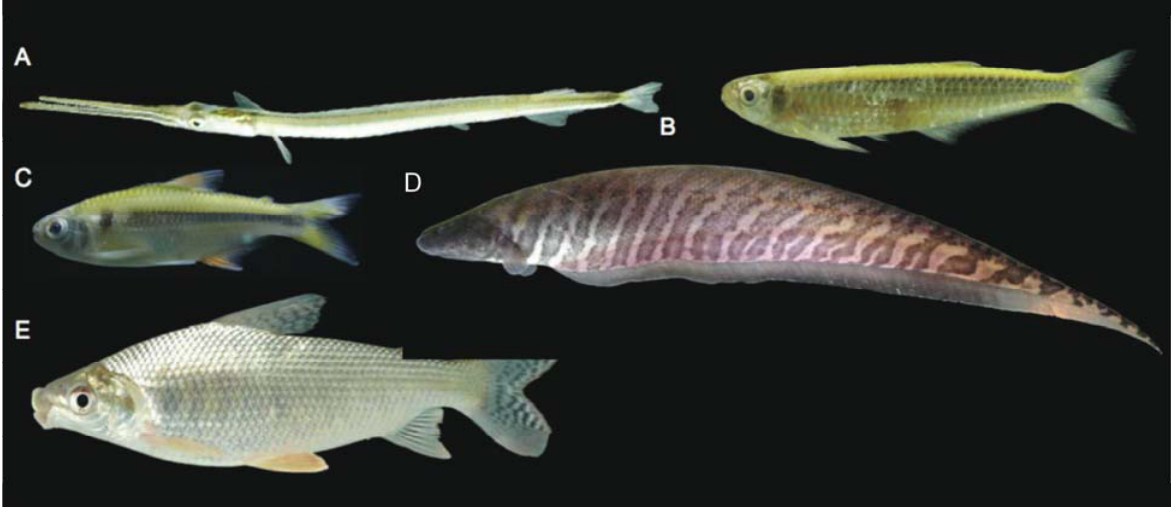
Figure 8. Examples of species collected in all three basins. (A) Pseudotylosurus angusticeps (73 mm). (B) Clupeacharax anchoveoides (67 mm). (C) Knodus